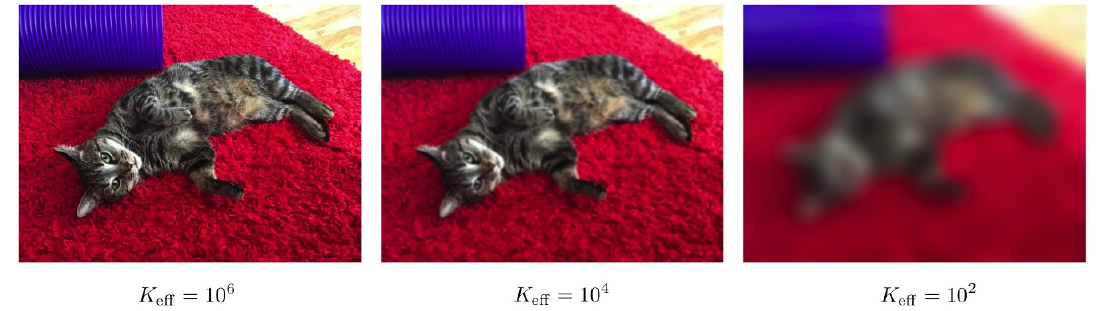
Figure 7 . Schr(cid:127)odinger’s cat, coarse grained with a Gaussian kernel W ‘ ( x ) / e (cid:0) x 2 = 2 ‘ 2 , for ‘ = 1 ; 10 ; 100, in an area of size V = 10 7 . In two dimensions, this corresponds to an e(cid:11)ective number of pixels equal to K e(cid:11) = V (cid:25) 10 6 ; 10 4 ; 10 2 . Realizing the perturbative QFT Heisenberg algebra 4 (cid:25)‘ 2 at a resolution K e(cid:11) requires N & 3 K e(cid:11)